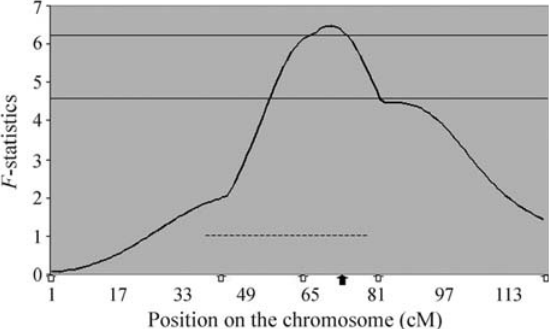
Figure2 -TheF-statisticforbodyweight(BW)onbovinechromosome5. The upper and lower horizontal lines represent the threshold levels at 1% (F = 6.44) and at 5% (4.67). The white arrows under the axis indicate the marker positions in chromosome: BM6026 (0.0 cM), BM321 (43.3 cM), BMS490 (64.4 cM), BMS1617 (81.4 cM) and BMS1248 (121.7 cM). The QTL located 69 cM from the centromere (F = 6.49). The black arrow indi - cates the position of the igf-1 gene (66.3 cM) adapted from MARC and consider BM6026 the most centromeric marker. The dotted line indicates the confidence interval (39-79 cM) for the